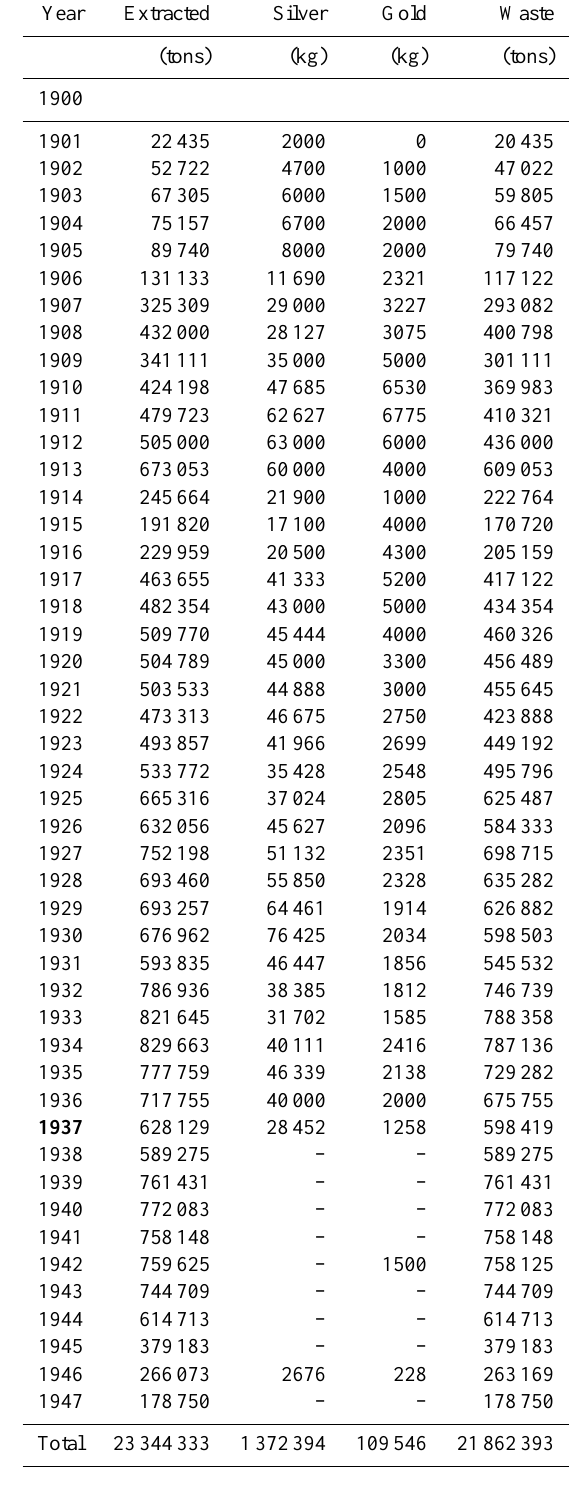
Table 1. Summary of extracted metals and amount of waste pro- duced at